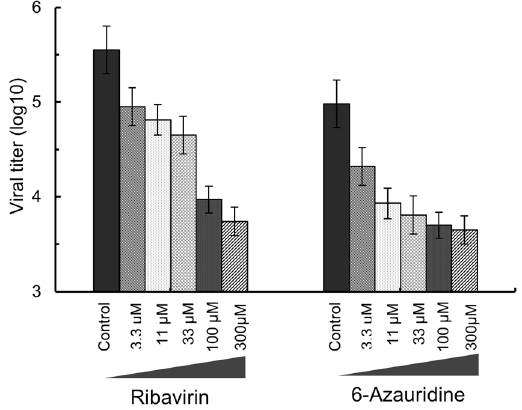
Figure 8. The reporter replicon particles can be used for antiviral drug discovery. BWNV-CME cells were infected with the indicated viruses at an MOI of 0.1; the infected cells were immediately treated with ribavirin and 6-Azauridine. For WNV, the culture media were collected at 30 h and viral titres were measured using plaque